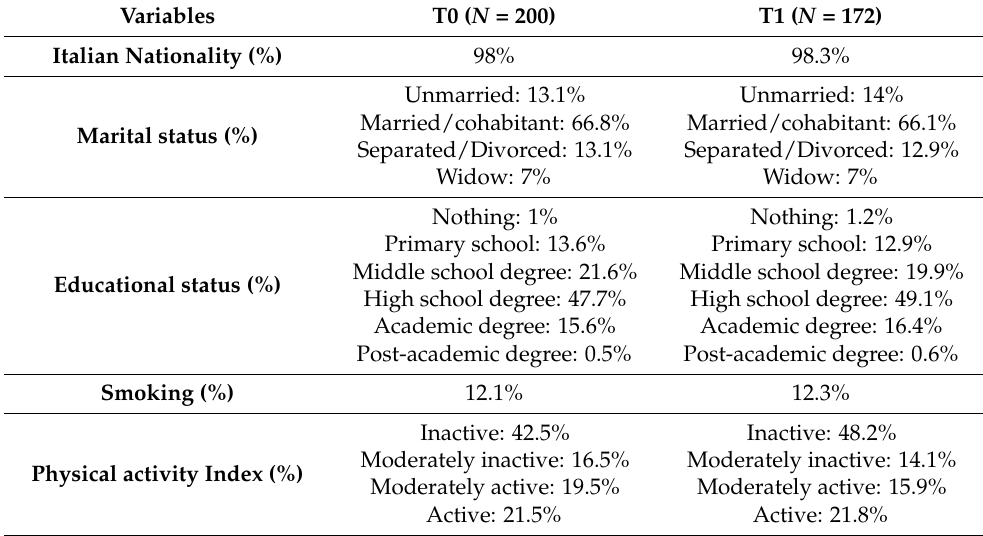
Table 1. Socio-demographic characteristics and lifestyle habits of the population at T0 and T1, descriptive statistics (percentages of frequency). No statistical differences between T0 and T1 were